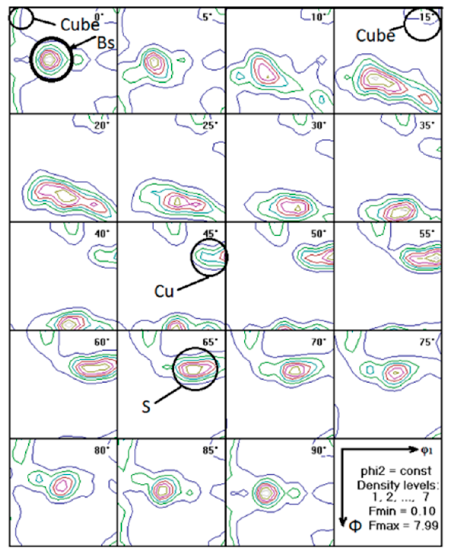
Figure 15. ODF for the state after annealing at 250 °C with a 3-h exposure.